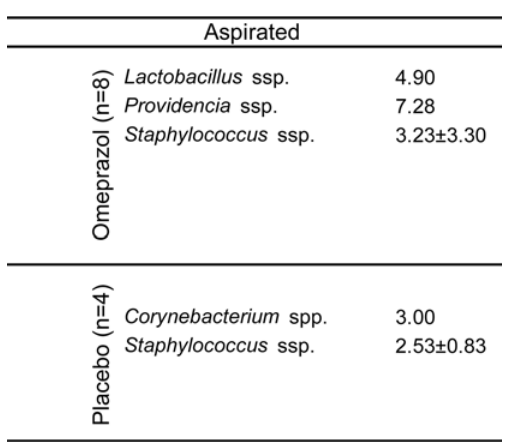
TABLE 4 - Bacteria strain [Ln(UFC/ml)] (mean ± SD or unit value) obtained by aspíration after administration of omeprazol/placebo.